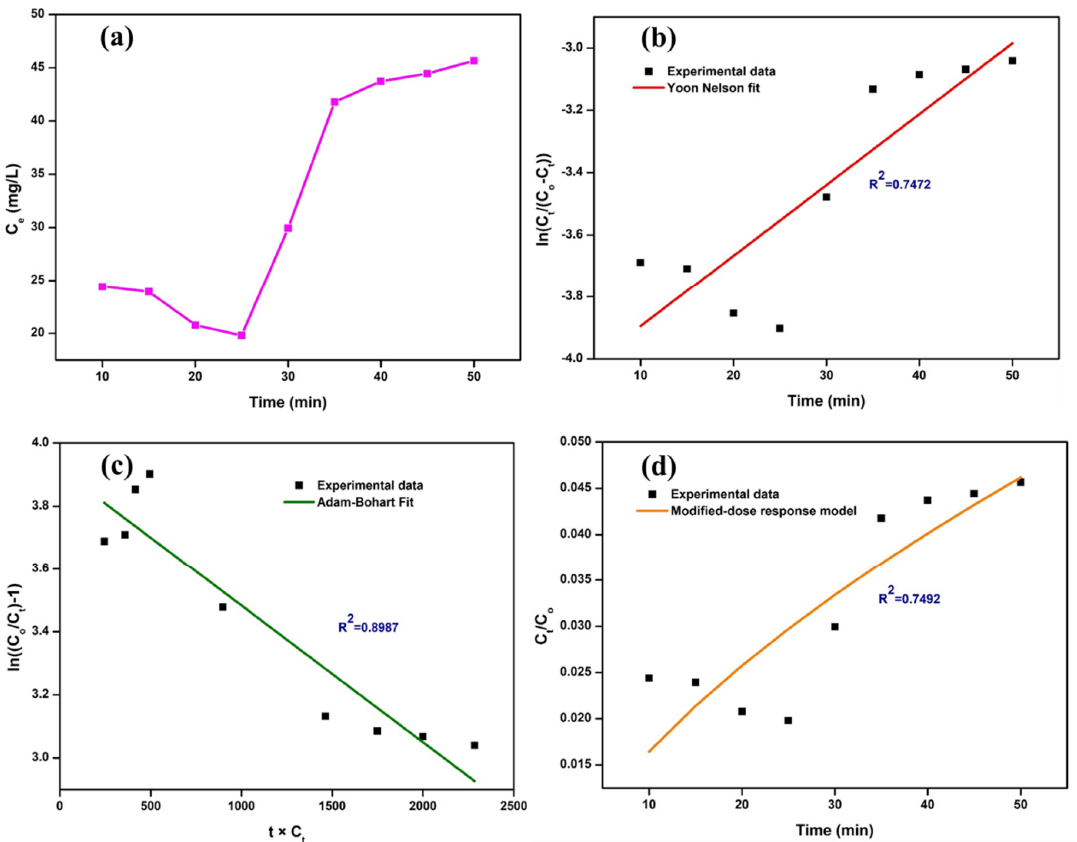
Figure 6. ( a ) Phenol-activated carbon breakthrough curve analysis; ( b ) Yoon-Nelson fit model; ( c ) Adam–Bohart fit model; and ( d ) modified-dose response